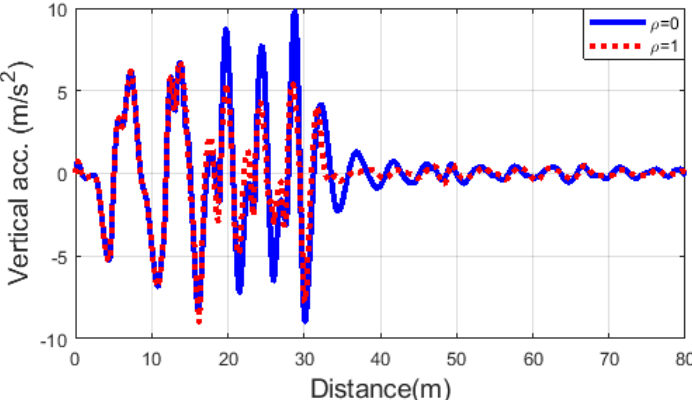
Figure 16. Vertical acceleration of road roughness.